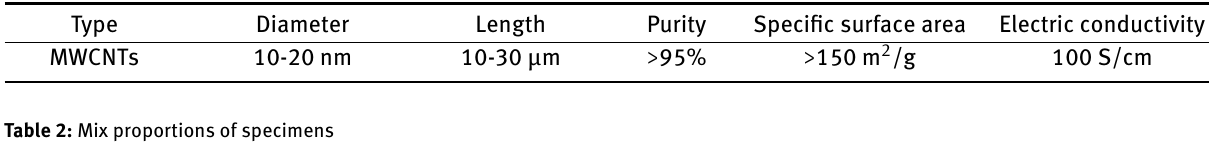
Table 1: Properties of the MWCNTs used in this study.